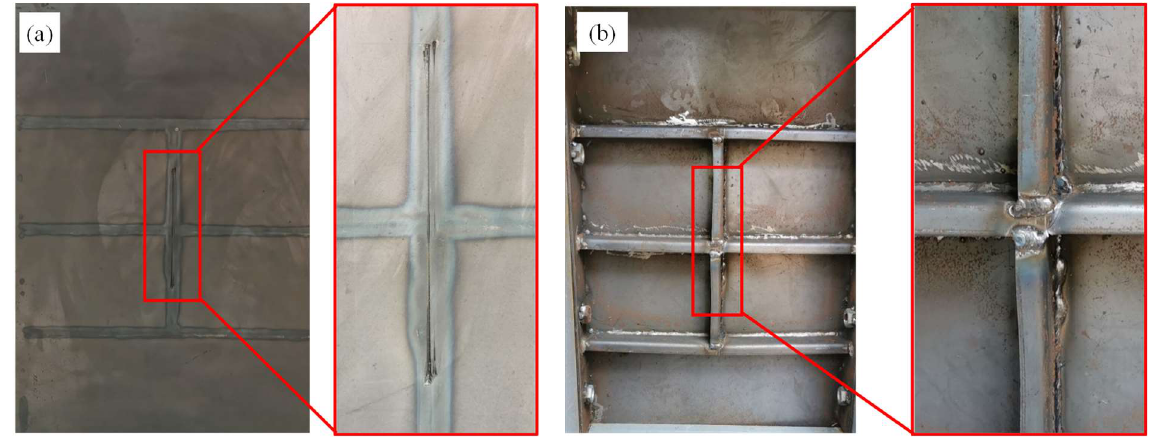
Figure 11. Deformation of the strengthened stiffened plate under centric impact: ( a ) front side; ( b ) back side.